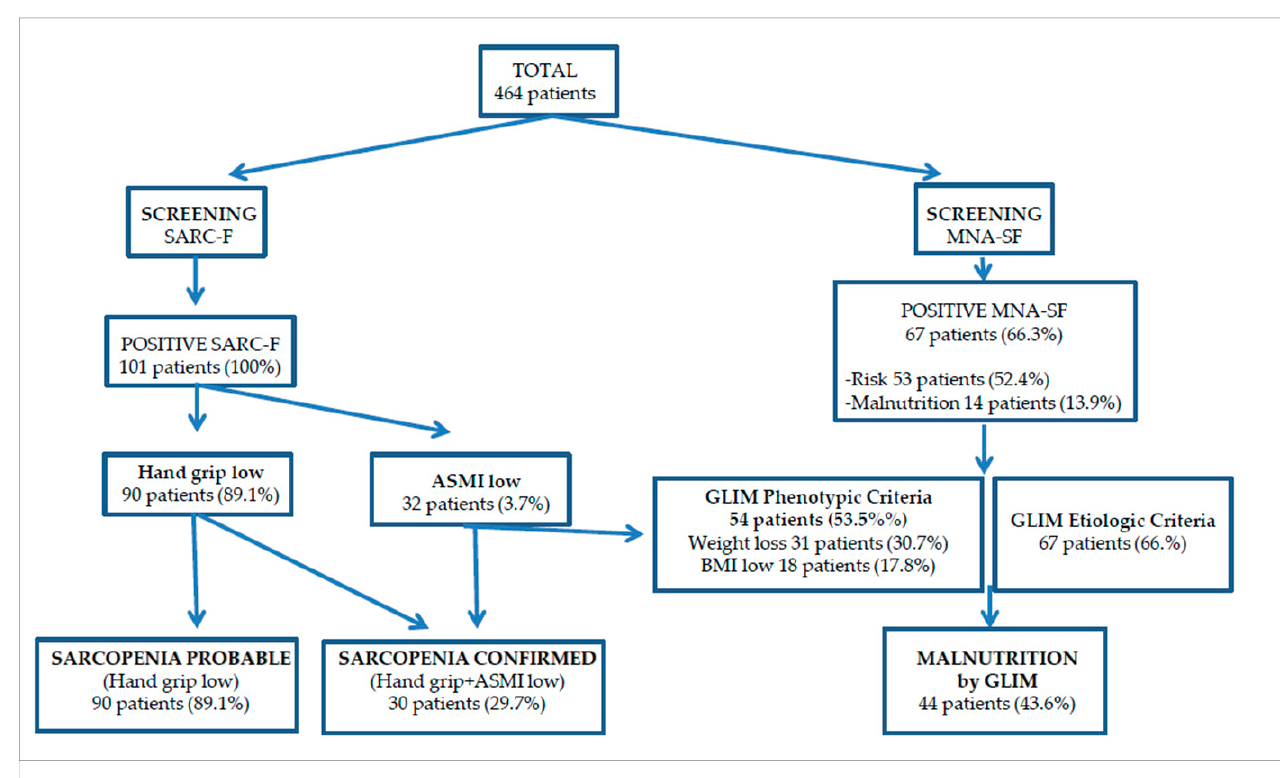
Figure 2. Flow chart for the diagnosis of sarcopenia and malnutrition.